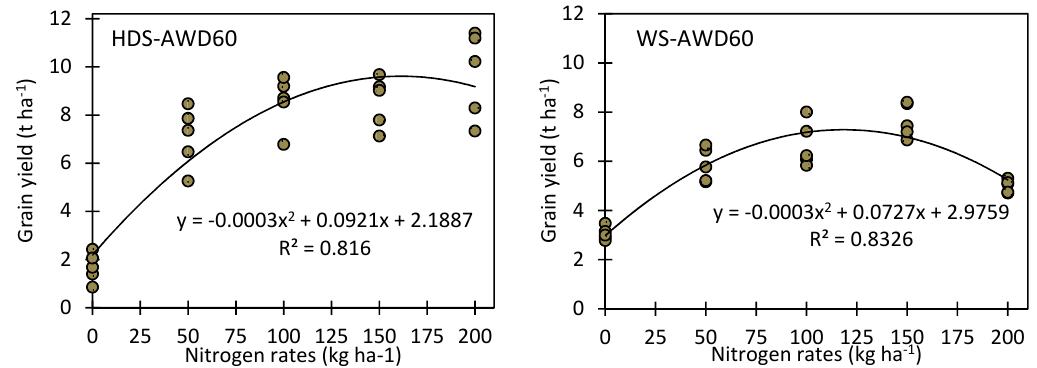
Figure 5. Rice yield-nitrogen production functions under different irrigation regimes and during the hot and dry season and the wet season.